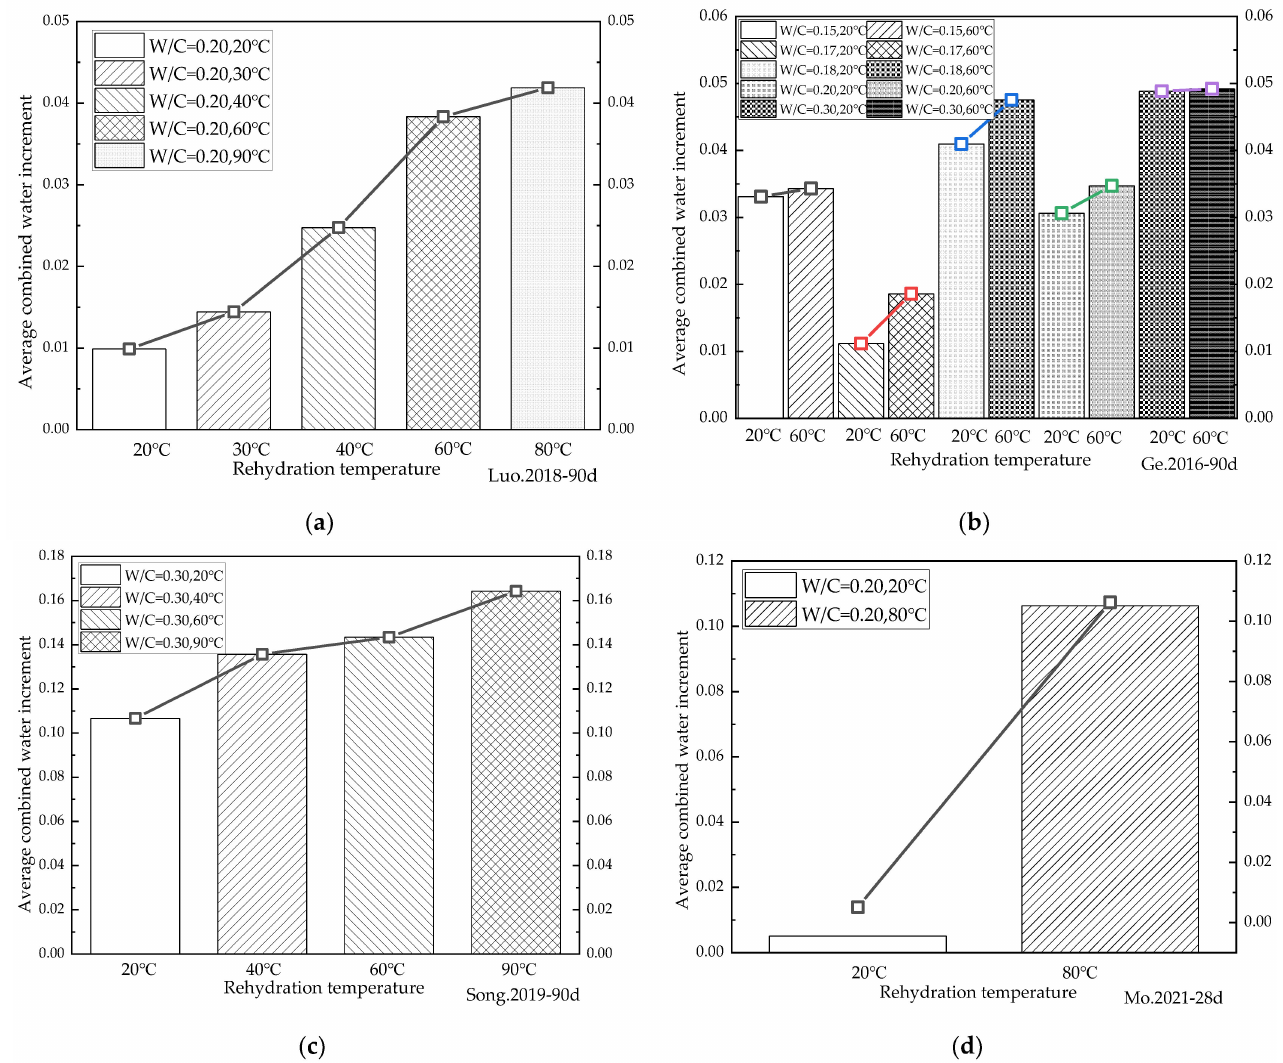
Figure 9. Variation in the average increment in the chemical combined water at different rehydration temperatures. ( a ) [40] 90d average growth rate at different rehydration temperatures; ( b ) [45] 90d average growth rate at different rehydration temperatures; ( c ) [50] 90d average growth rate at different rehydration temperatures; ( d ) [55] 28d average growth rate at different rehydration